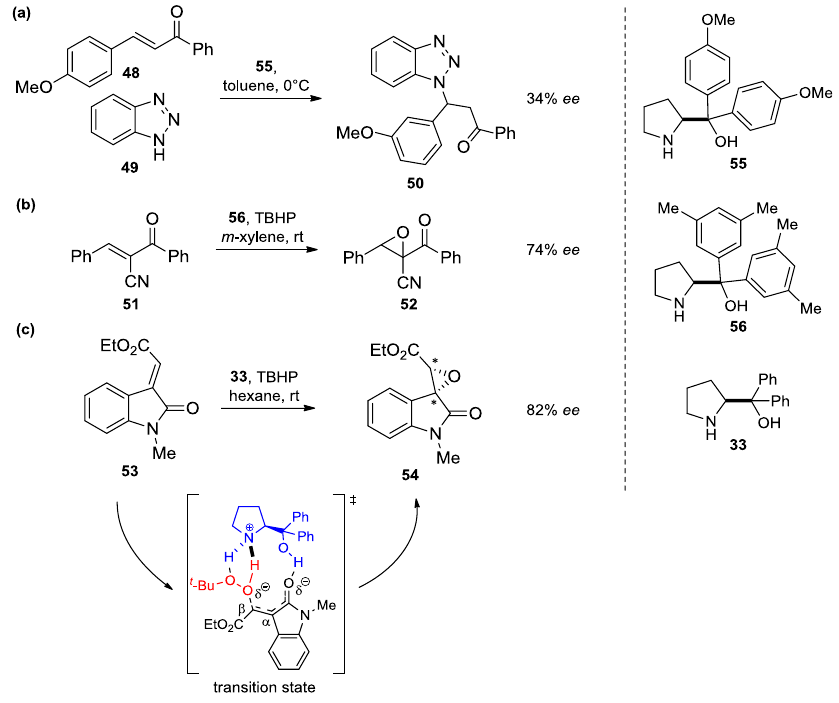
Figure 14. Enantioselective conjugate addition of N-heterocycles to α , β -enones (a), from Ref. [64]; epoxidation of acrylonitriles (b), from Ref. [67]; epoxidation of α -ylidenoxindoles (c), from Ref. [68].